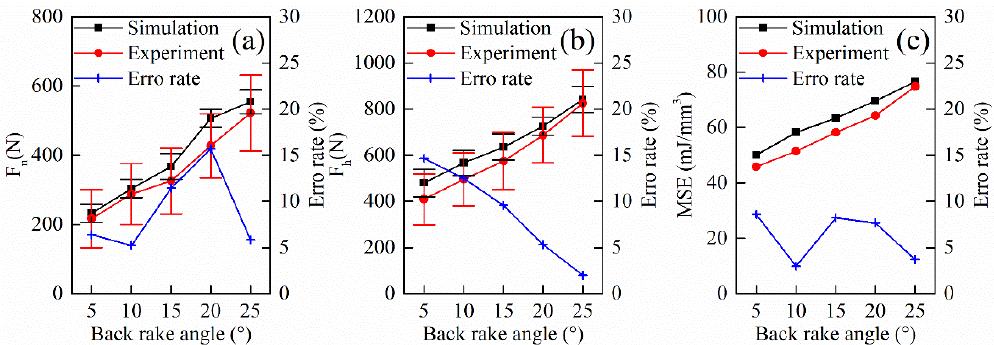
Figure 6. Comparison between the numerical and experimental results: ( a ) The axial force; ( b ) The tangential force; ( c ) The Mechanical Specific Energy (MSE).